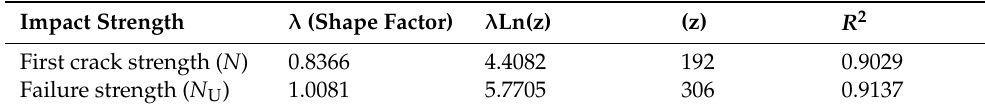
Table 4. The Weibull distribution analysis result.